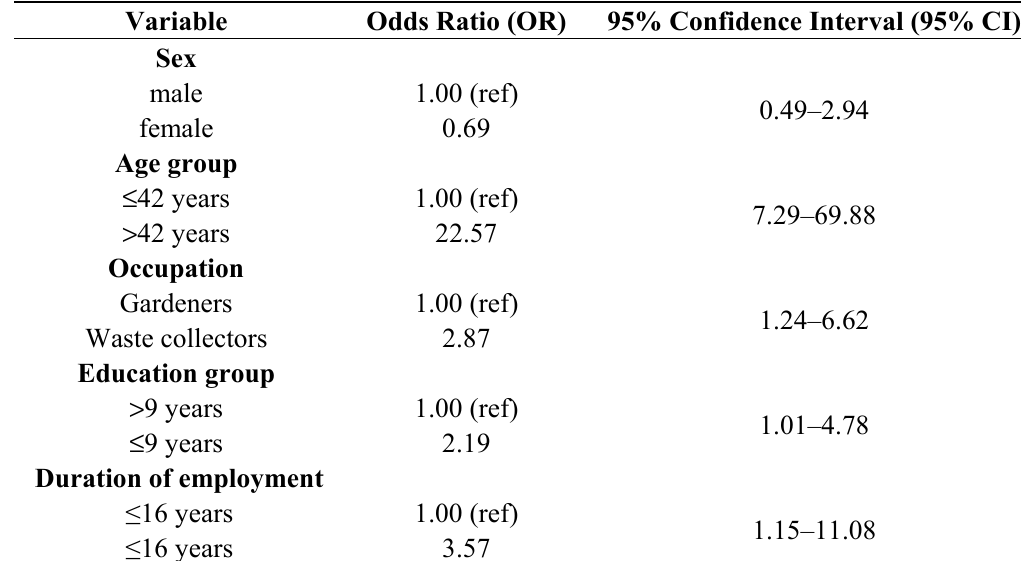
Table 3. Multivariate analysis of Anti-H Α V (+) among municipal workers (waste collectors vs .